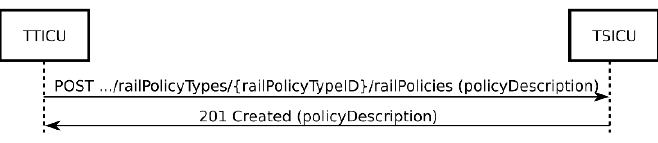
Figure 7. Flow of the rail policy creation procedure.